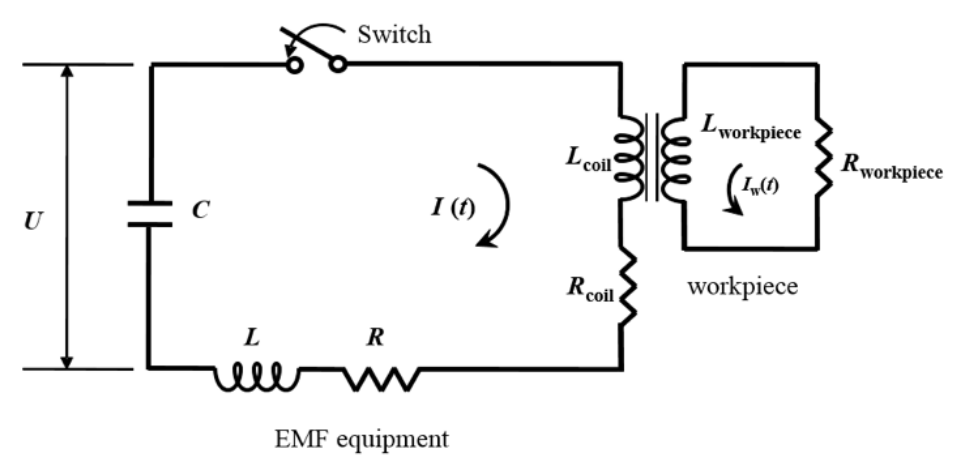
Figure 2. RLC equivalent circuit diagram of the EMF equipment and a workpiece.